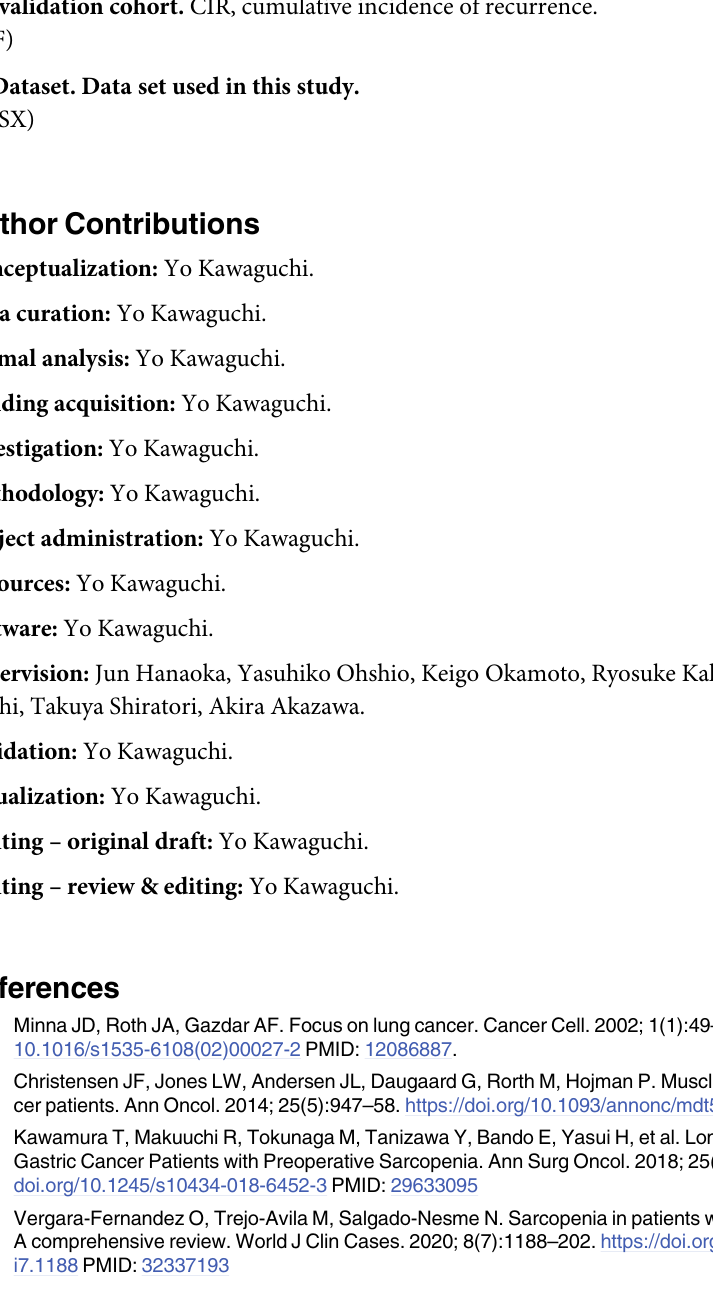
S1 Fig. ROC curve for predicting recurrence using sarcopenia. ROC, receiver operating characteristic. (TIF) S2 Fig. OS and DFS after surgery compared between sarcopenia patients and non-sarcope- nia patients in the validation cohort. DFS, disease-free survival; OS, overall survival. (TIF) S3 Fig. CIR rate after surgery between sarcopenia patients and non-sarcopenia patients in the validation cohort. CIR, cumulative incidence of recurrence. S1 Dataset. Data set used in this